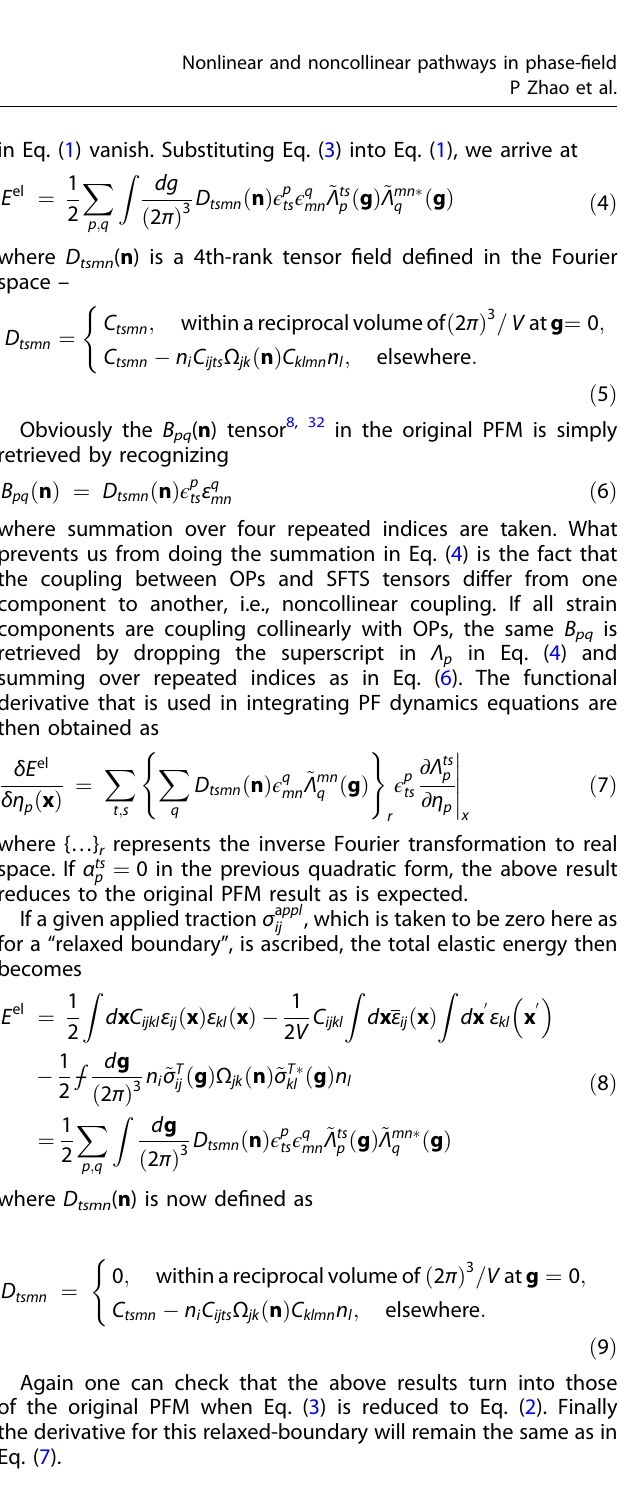
Table 1. Different transformation pathways in the form Λ